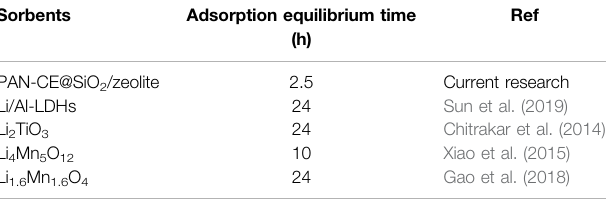
TABLE 1 | Adsorption performance of sorbents for Li( Ι ) in other research. Sorbents